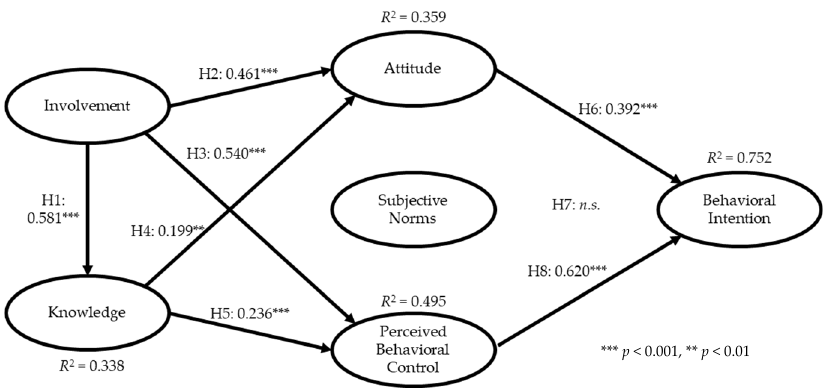
Figure 2. Conceptual model and structural equation modeling (SEM) results.